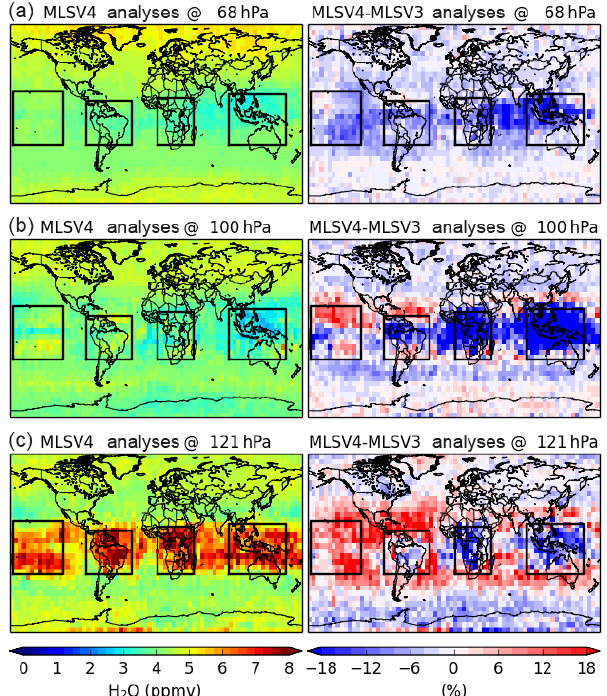
Figure 20. Monthly averaged H 2 O analyses in the MIPAS space in January 2012 using the MLS V4 data set (left) and relative differ- ence between the MLS analyses using V4 and V3 data sets (right) at 121hPa (c) , 100hPa (b) and 68hPa (a)